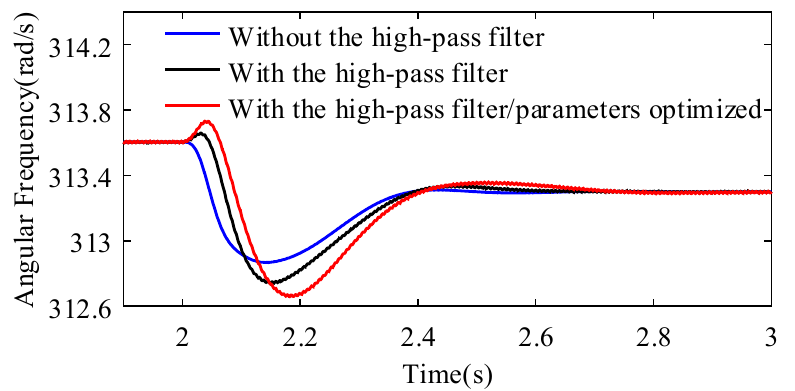
Figure 13. The simulation result of VSG angular frequency with the asynchronous motor load.